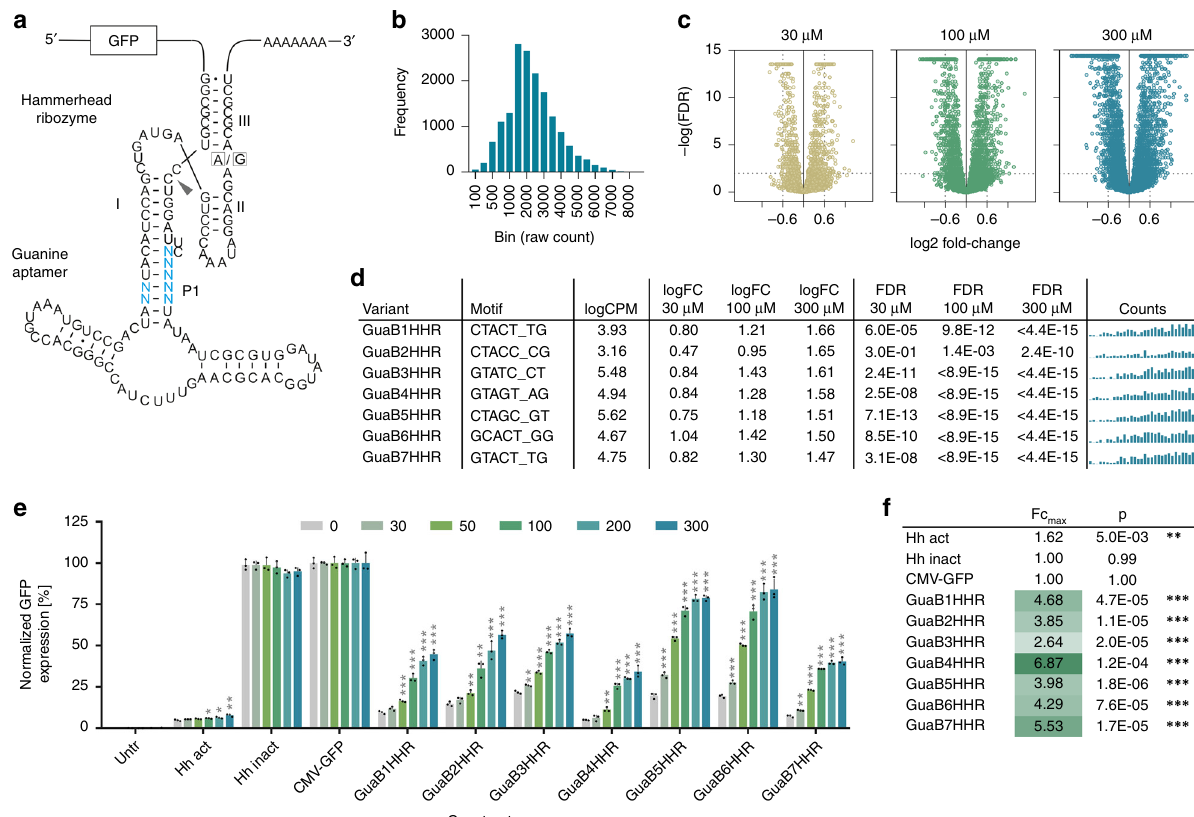
Fig. 4 Identi fi cation of Gua-responsive hammerhead ribozymes by amplicon-seq. a Secondary structure of the guanine hammerhead ribozyme library design. Blue nucleotides indicate the randomized motif. The arrowhead indicates the cleavage site. A/G mutation at the indicated position renders the ribozyme inactive. b Guanine riboswitch construct frequency analysis of the original library. c Volcano plots displaying the signi fi cance (FDR) of changes in riboswitch abundance as a function of the change in expression (log 2 fold change). d Selected hits from the Gua-HHR riboswitch library screen, randomized sequence, mean counts per million (CPM), fold change (FC) and false-discovery rate (FDR) at 30, 100, and 300 µ M guanine, respectively. The bar plots show the raw counts under untreated, 30, 100, and 300 µ M µ M Gua-stimulated conditions (four groups from left to right, n = 8 replicates each). e Functional hit validation in HEK-293 cells at increasing guanine doses [ µ M] ( n = 3 replicates, mean ± s.d.); Hh-act/inact: constitutively active/inactive ribozyme control. f Maximal fold changes and p-values measured upon stimulation vs. 0 µ M guanine for all tested constructs. * p < 0.05, ** p < 0.01, *** p